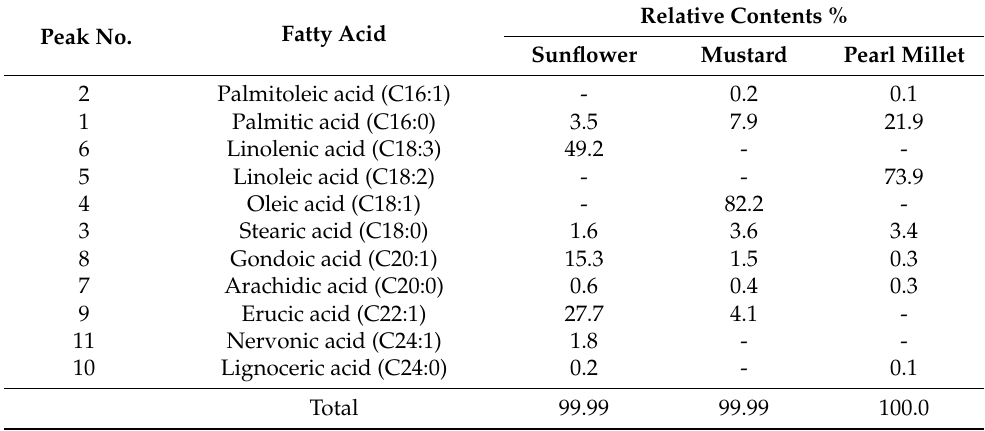
Table 6. Fatty acid profile of biodiesel from sunflower, mustard, and pearl millet seed oils. Peak